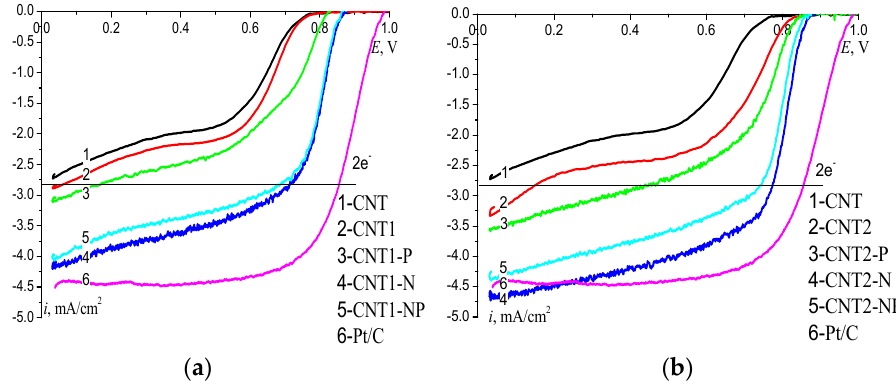
Figure 3. Polarization curves of O 2 reduction on modified CNTs functionalized: ( a ) in NaOH and ( b ) in HNO 3 ; O 2 -saturated 0.1 M KOH, the potential scan rate is 5 mV/s, w = 157 rad/s; m cnt = 0.15 mg/cm 2 .